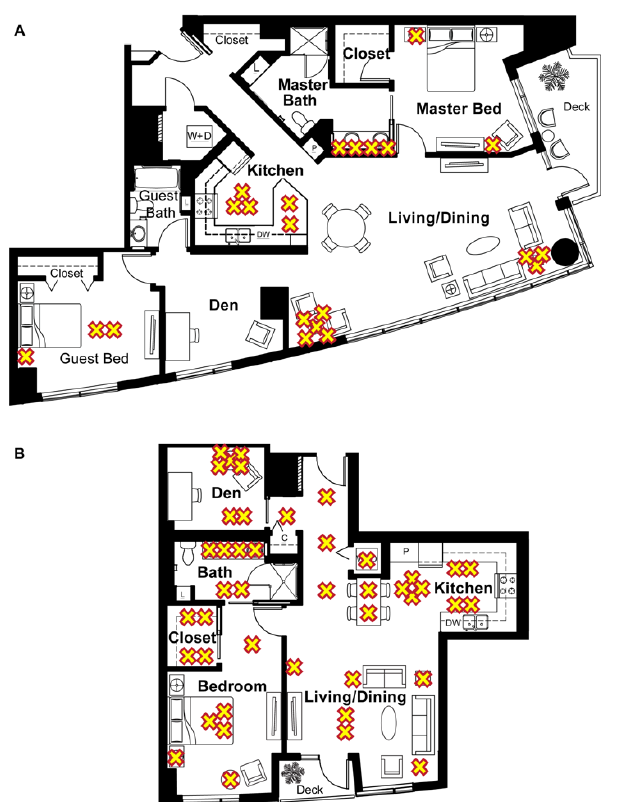
Figure 2. Floor plans of the homes included in the study and the approximate location of the light fixtures, indicated by a yellow “X”. ( A ) Floor plan of home 1286, a two-bedroom unit with n = 2 subjects and n = 22 lights. ( B ) Floor plan of home 1422, a one-bedroom unit with n = 1 subject and n = 43 lights.